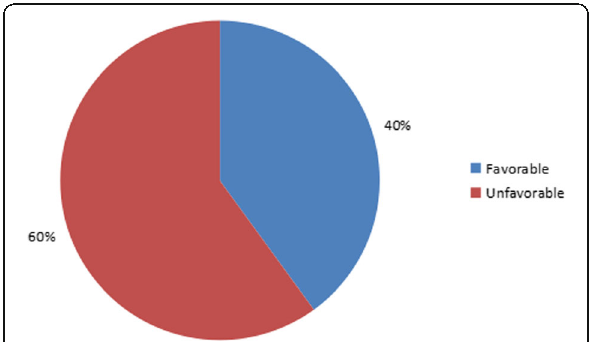
Fig. 2 Outcome of the studied